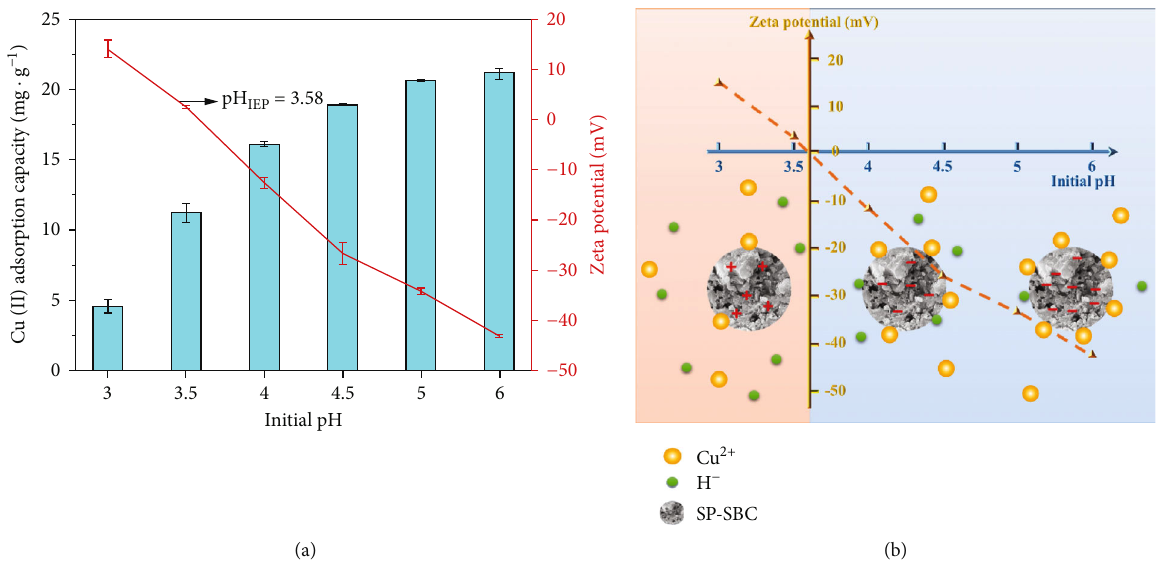
Figure 7: (a) E ff ect of initial pH on the adsorption capacity of SP-SBC for Cu(II), and (b) an illustration of the e ff ect of initial pH on Cu(II) adsorption by SP-SBC. Figure 6. With increased SP-SBC dosage (from 0.5 g · L − 1 to 10 g · L − 1 ), the Cu(II)-adsorption capacity decreased ( p < 0 : 05 ) from 26.06 mg · g − 1 to 4.983 mg · g − 1 , in accordance